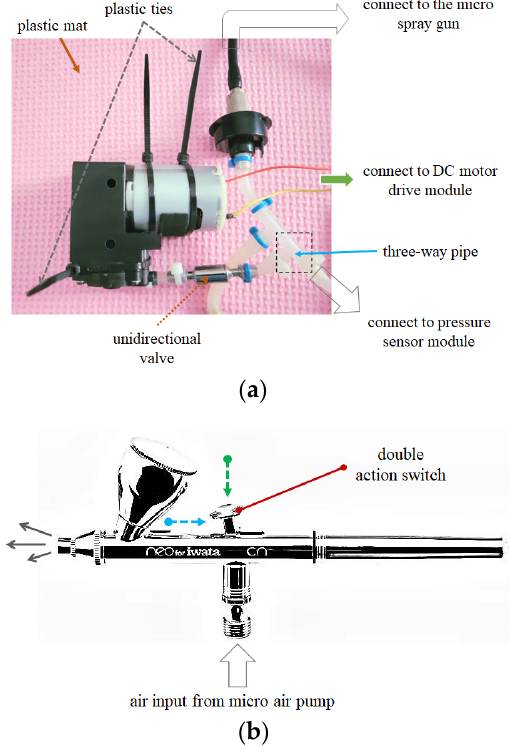
Figure 4. Micro air pump and micro spray gun configuration. ( a ) Picture of micro air pump fixed on the plastic mat material and the I/O contact layout. ( b ) Picture of micro spray gun and the schematic diagram of exhaust switch start. The green arrow stands for pressing down the switch, and the blue arrow reveals pressing the switch to the back of the spray gun.